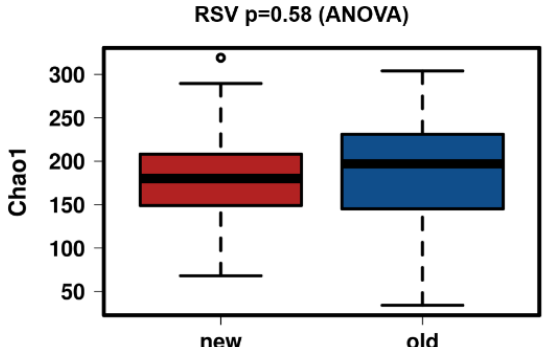
Figure 1. The mean diversity benchmark value for “healthy western skin” as found in this study is ~180. Alpha diversity boxplots using Chao1 showing the new benchmark of diversity found in this study (red) and comparing it with the results from our previous work (blue). There are no significant changes in alpha diversity between the studies. The black lines indicate average diversity. Samples were rarefied to 6600, so plots were visually comparable to others in this study.